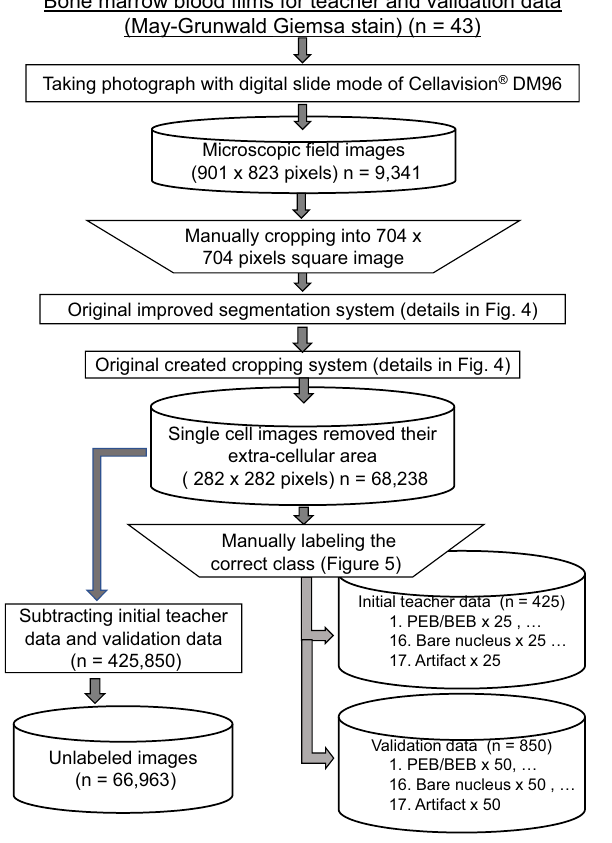
Current teacher data (labeled)